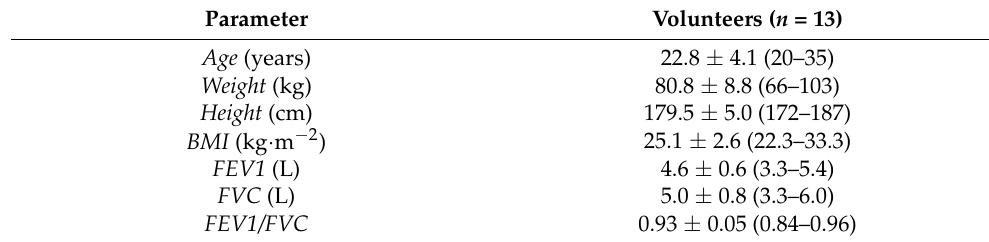
Table 2. The characteristics of the group of volunteers included in the data